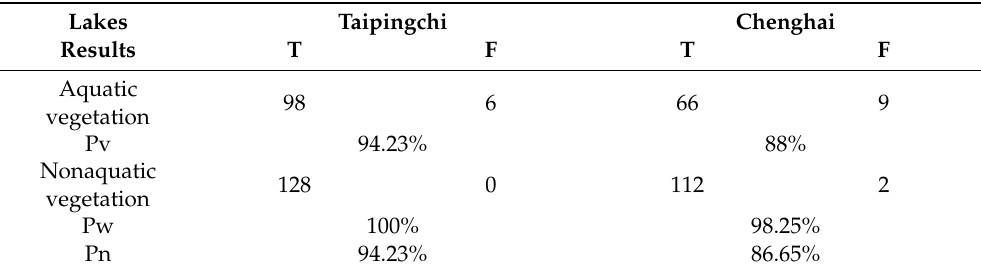
F represents points verified as incorrect, i.e., the points within the aquatic vegetation range without significant vegetation growth in the area or within the buffer zone outside the aquatic vegetation range, where the occurrence of aquatic vegetation was verified. Pn represents the accuracy of aquatic vegetation extraction for lake n.